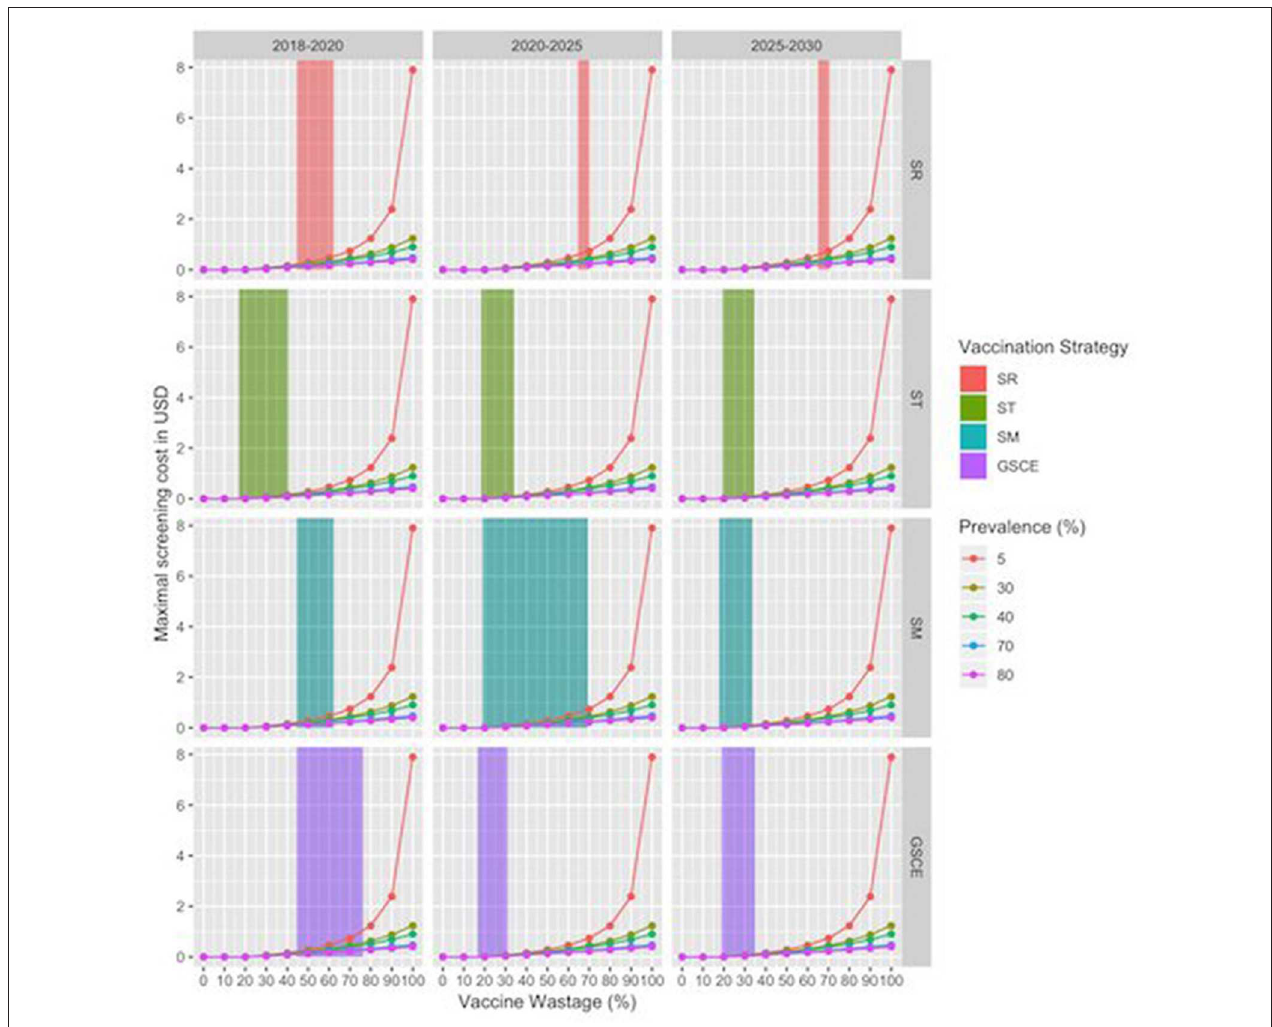
FIGURE 9 | Maximal Screening cost per animal by vaccination strategy and period. X-axes correspond to the vaccine wastage, while y axis corresponds to maximal screening cost, zero value indicating that the procedure is not convenient. Line colors correspond to the evaluation for different sero-prevalence values. Shaded areas correspond to range of vaccination wastage in that period by vaccination